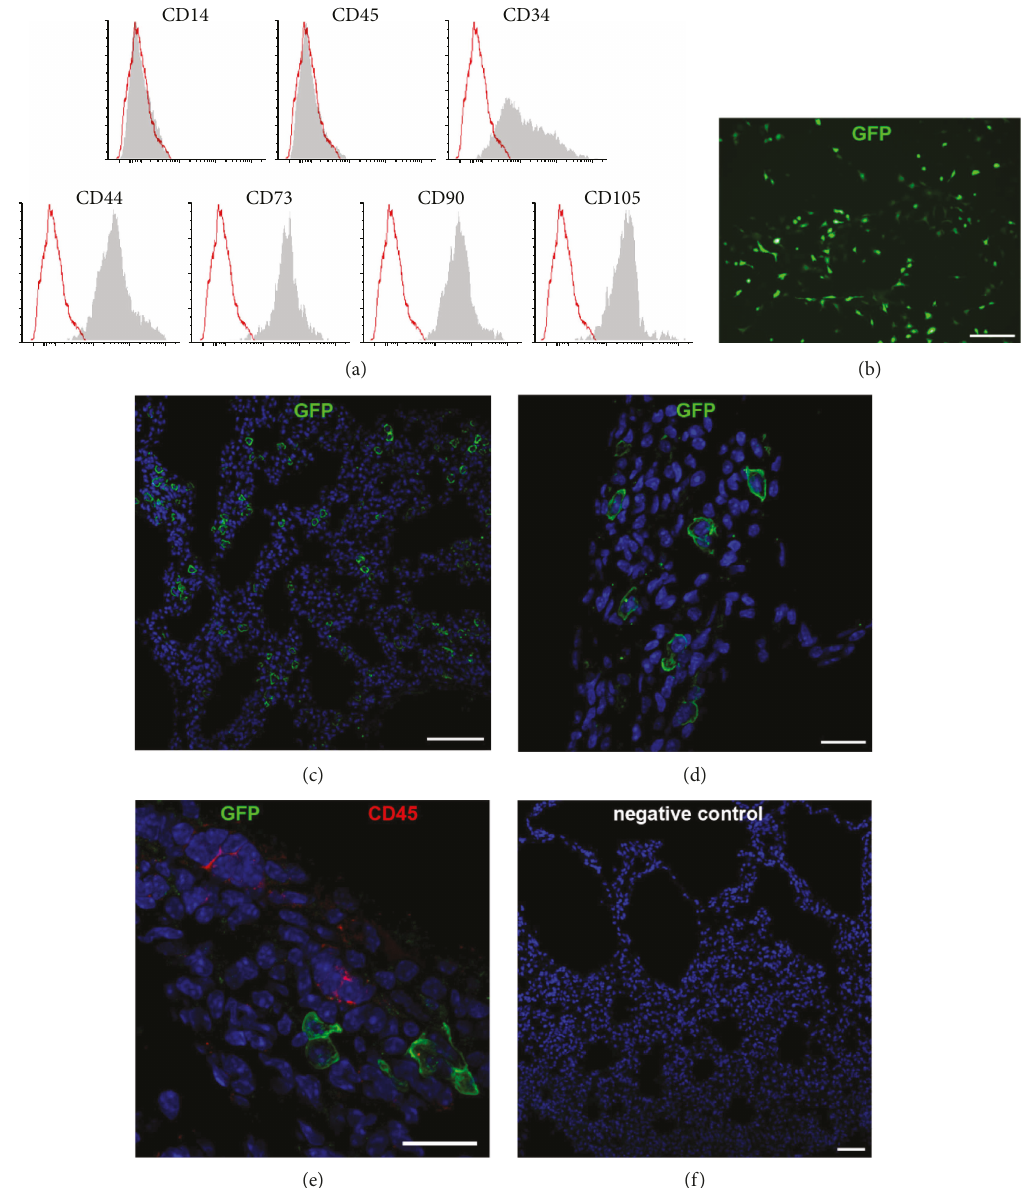
Figure 1: MSC characterization and engraftment. (a) Immunophenotypic pro fi le by fl ow cytometry of MSCs isolated from adult mouse lungs. Grey-shaded peaks show CD markers; red histograms represent isotype control. (b) Representative image of MSCs after lentiviral transduction of GFP (green). (c, d) In vivo engraftment of GFP-positive MSCs (green) in emphysematous lungs ten days after intratracheal cell administration. (e) Representative image of GFP-positive MSCs (green) and CD45-positive cells (red). (f) Negative control for GFP staining in a PPE lung. Nuclei are counterstained with DAPI (blue). Scale bars: 20 μ m (d, e), 50 μ m (b, f), and 100 μ m